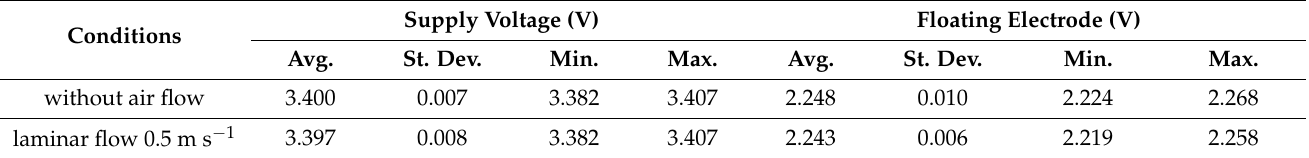
Table 1. Stability of the raw sensor output signals during 20 s of measurements with a frequency of 50 Hz. Conditions